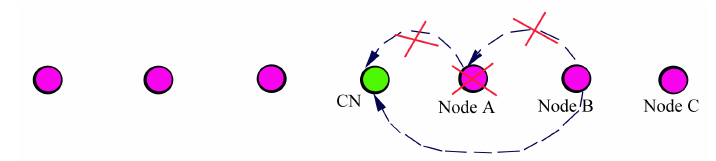
Figure 5. Example showing the